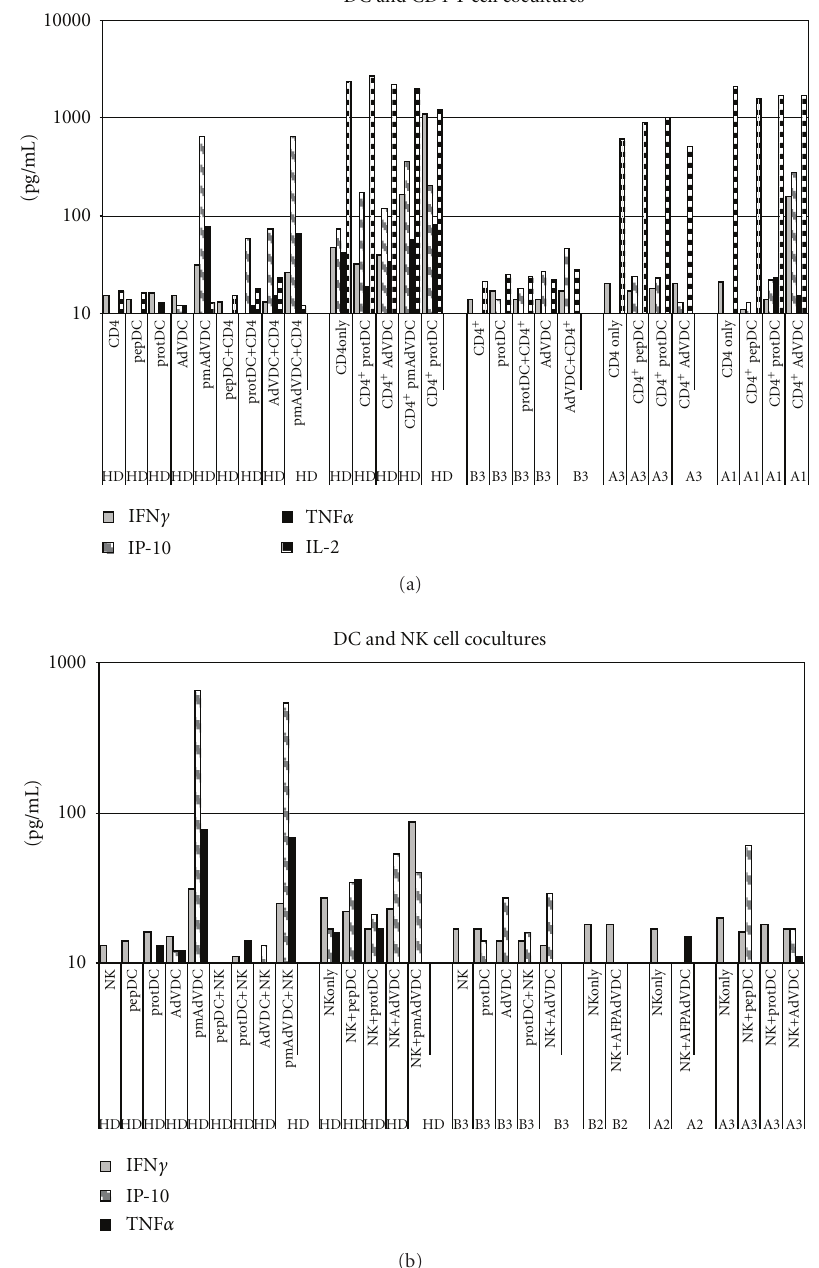
Figure 6: Luminex results: production of chemokines and cytokines. Graphs are grouped according to scale of cytokine production and function. (a) IFN- γ , IP-10, TNF- α , and IL-2 production after CD4 + DC coculture. (b) MCP-1 and IL-5 production after CD4 + DC co-